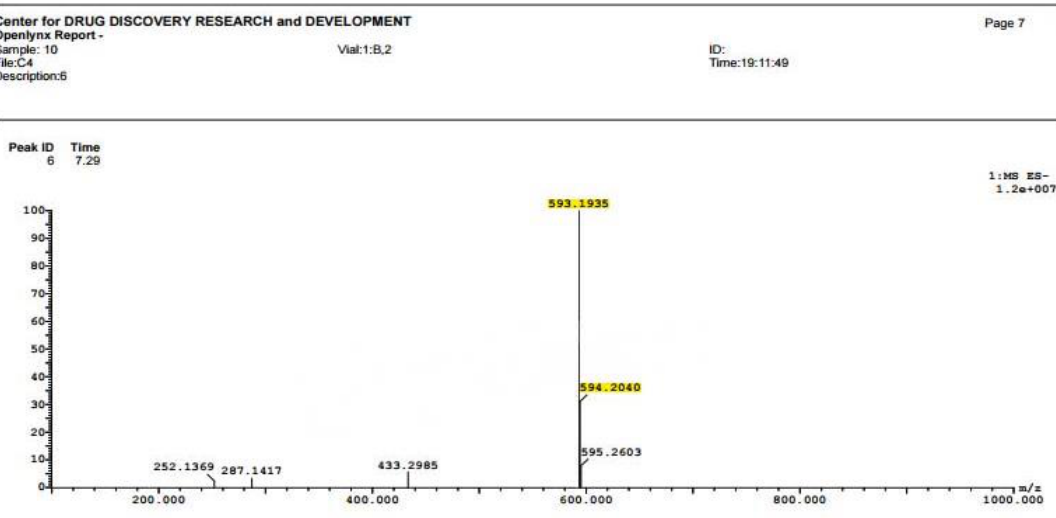
Figure 20. First mass for peak 6 at retention time 7.29 min with molecular ion [M-H] 593.1935 from n- butanol.